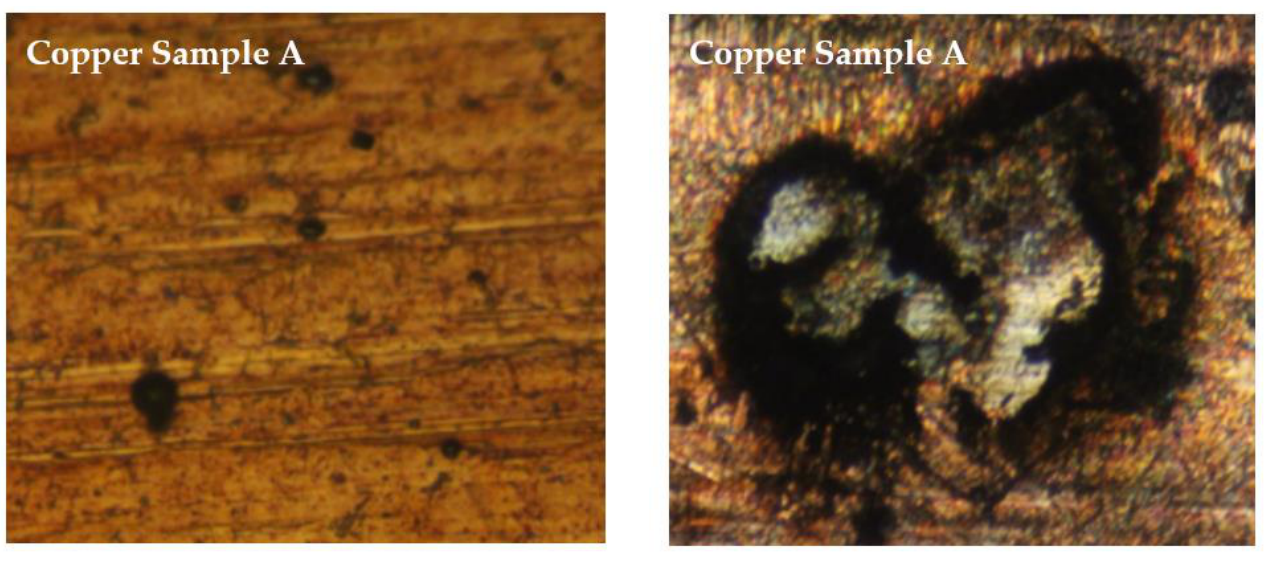
Figure 8. The copper contact surface. ( a ) The new copper contact surface under a microscope. ( b ) The same copper contact surface after being subjected to an electrical arc from normal contact. The current that passed through the contact was 4 A. Note that the copper surface loses its mass after the contact arc.